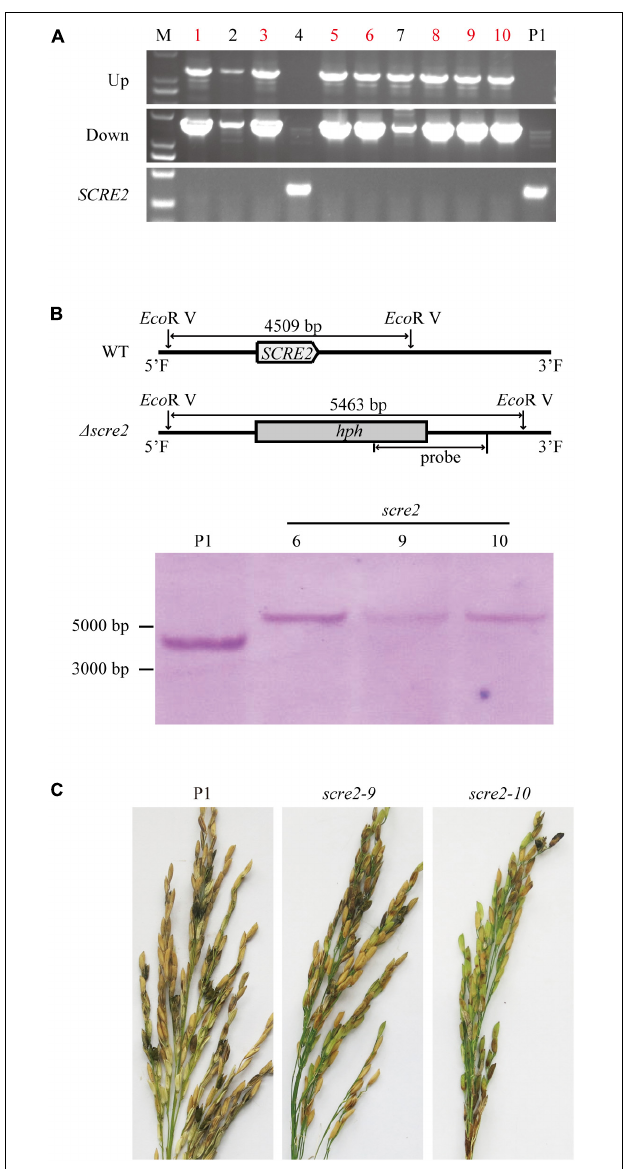
FIGURE 6 | SCRE2 is required for full virulence of U. virens to rice. (A) Screening of the SCRE2 knockout mutants by diagnostic PCR. The upstream and downstream flanking sequences of hygromycin phosphotransferase ( hph ) gene and the SCRE2 gene were amplified by PCR with designed primers, respectively ( Supplementary Figure S6 and Supplementary Table S2 ). The absence of the PCR product of SCRE2 and successful amplification of upstream and downstream jointing sequences of hph and SCRE2 indicate that SCRE2 is successfully replaced by hph gene via homologous recombination. The wild-type P1 strain was used as a negative control. M, molecular marker. (B) validation of the SCRE2 knockout mutants via Southern blot analysis. Genomic DNA was isolated from the wild-type P1, scre2 -6, scre2 -9, and scre2 -10 mutants and was then digested with Eco R V. After being separated on agarose gels, DNA was blotted onto nylon membrane. The digested DNA was then hybridized with isotope-labeled SCRE2 probe. (C) Disease symptoms on rice panicles were observed about 1 month after inoculation with the U. virens wild-type and mutant strains. The wild-type P1 and mutant strains including scre2 -9 and scre2 -10 were inject-inoculated into rice panicles of LYP9 at 5 ∼ 7 days before rice